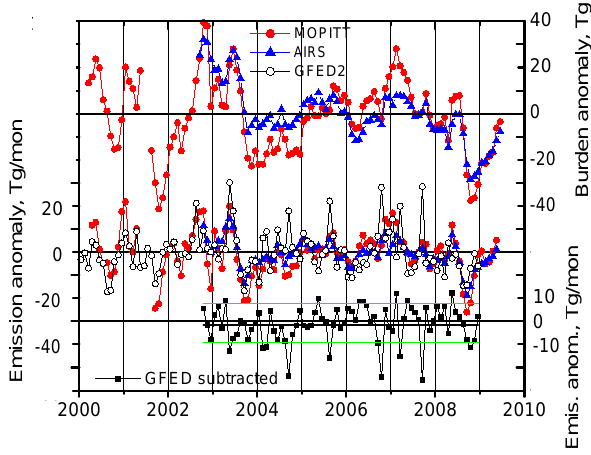
Fig. 10. Global CO emission anomalies derived from MOPITT and AIRS data and compared to GFED2. Top panel, right-hand scale: Anomalies of global (70 ◦ S to 70 ◦ N) monthly mean CO burden ob- served by the two satellite sounders. Middle panel, left-hand scale: Anomalies of monthly mean CO global emissions calculated from burden anomalies assuming the reaction with OH is the only sink for CO and [OH] according to Spivakovsky et al. (2000). Bottom panel, right-hand scale: Averaged MOPITT and AIRS emission anomalies minus fire CO emission anomalies from GFED2, representing all other changes except wild fires. Straight green lines correspond to ± STD.